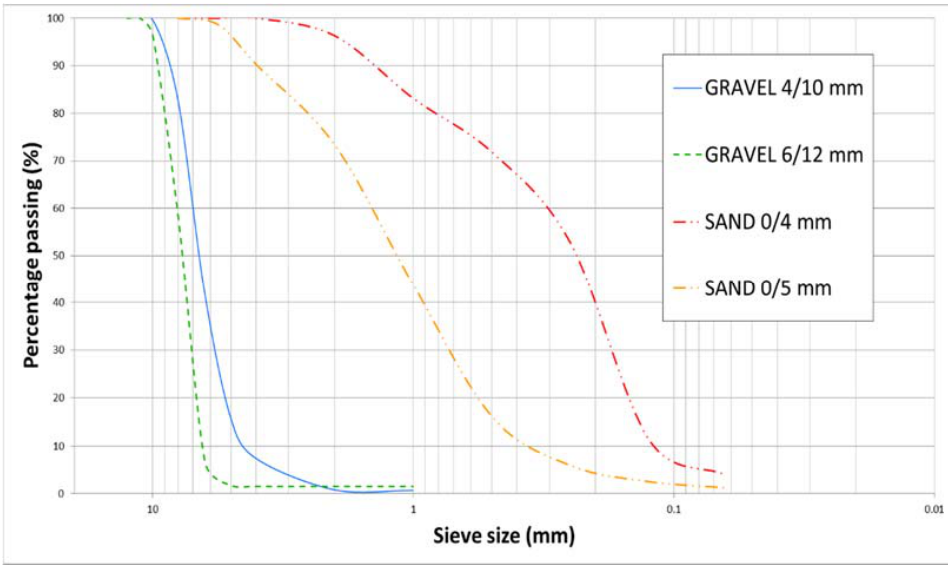
Figure 1. Particle size distribution of the natural (fine and coarse) aggregates used in the study.